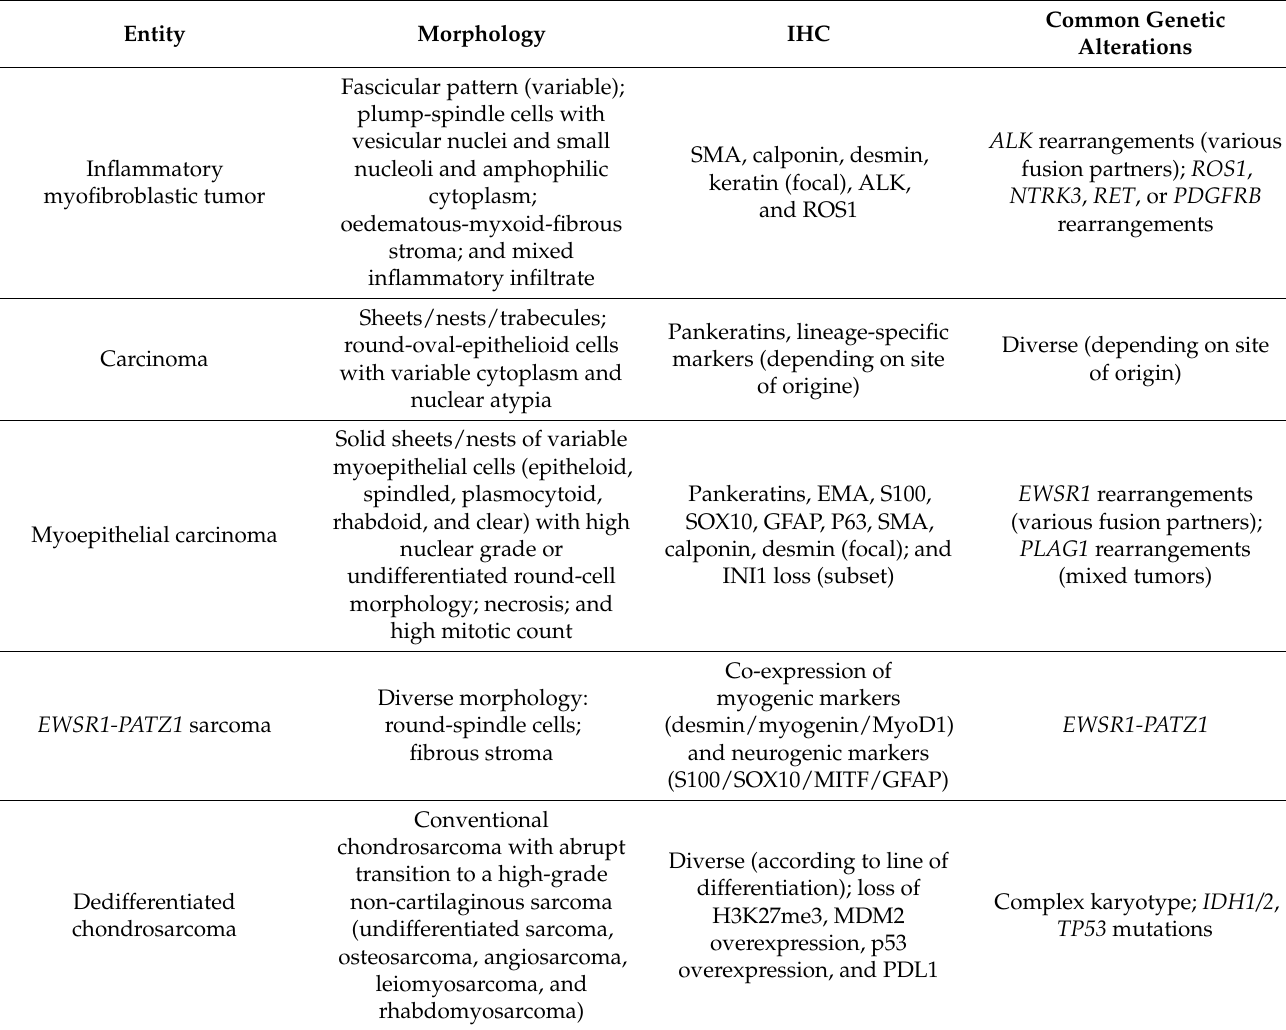
Table 13. Differential diagnoses of epithelioid and spindle cell